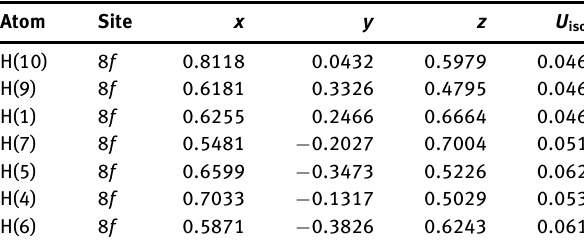
Table 2: Fractional atomic coordinates and isotropic or equivalent isotropic displacement parameters (Å 2